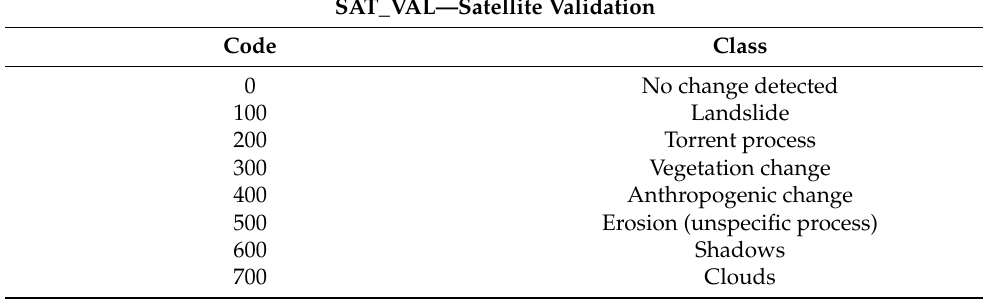
Table 4. ASTER validation assessment.